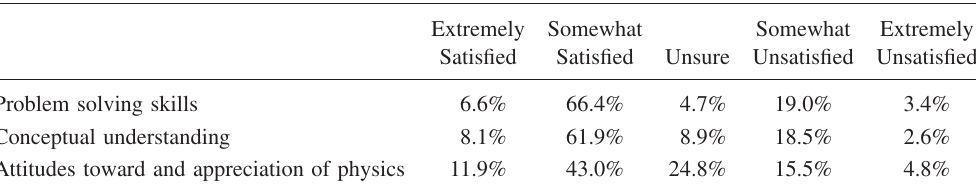
TABLE V. Satisfaction with extent to which students are meeting their instructional goals. This table only includes those respondents who rated the particular goal as very important.